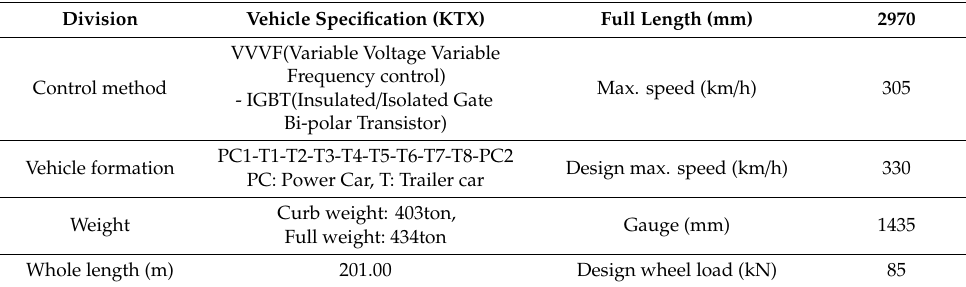
Table 6. Vehicle specification for trackside measurement.